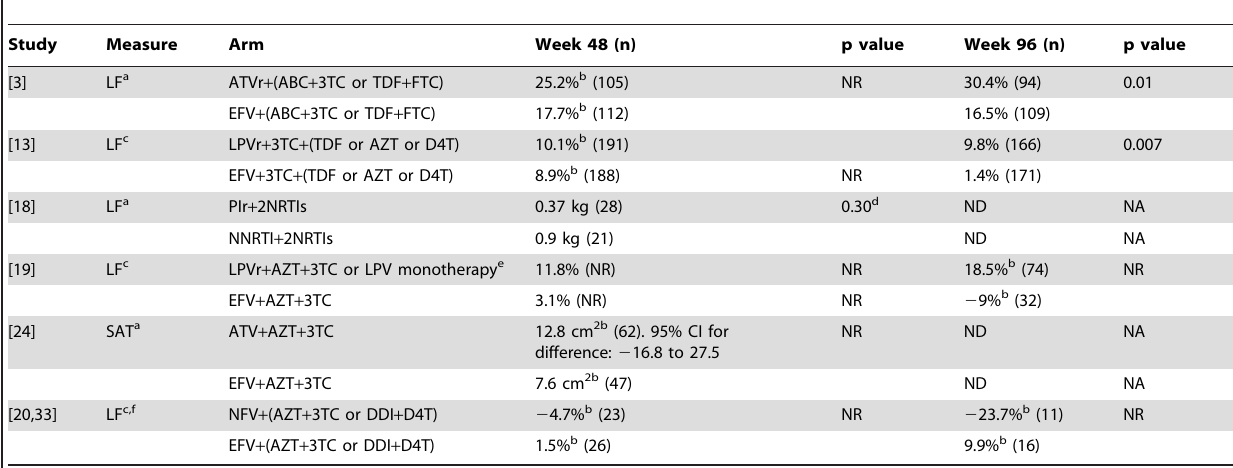
Table 3. Change from baseline in limb fat (LF) on DEXA scan and subcutaneous adipose tissue (SAT) on CT scan: PI versus NNRTI.